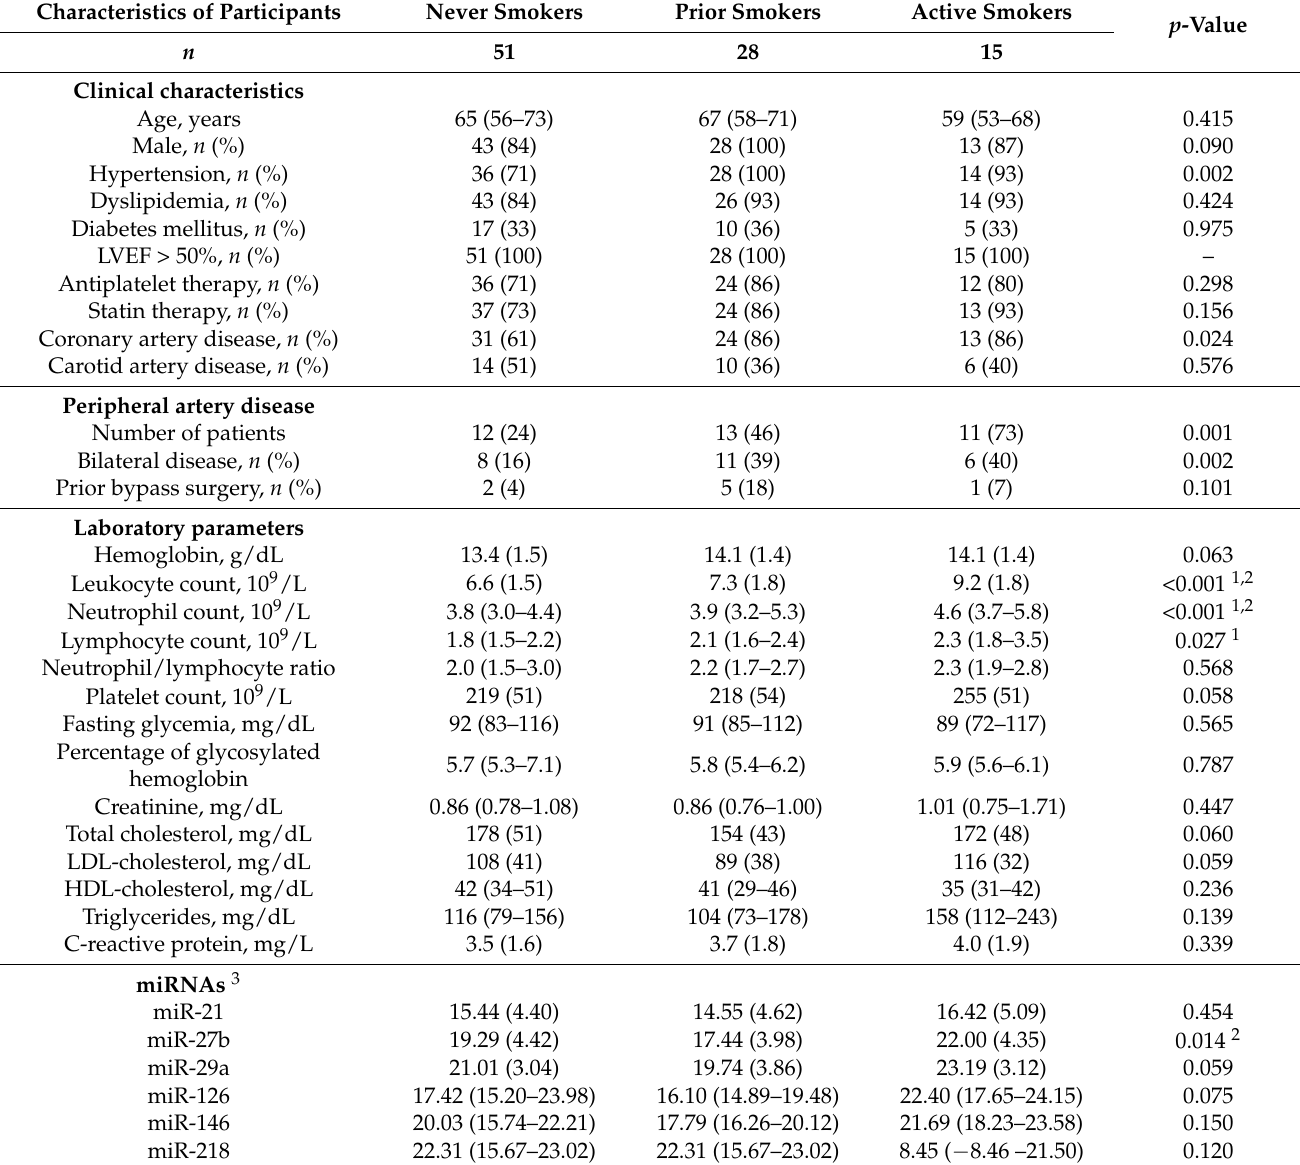
Table 2. Characteristics of participants according to cigarette-smoking